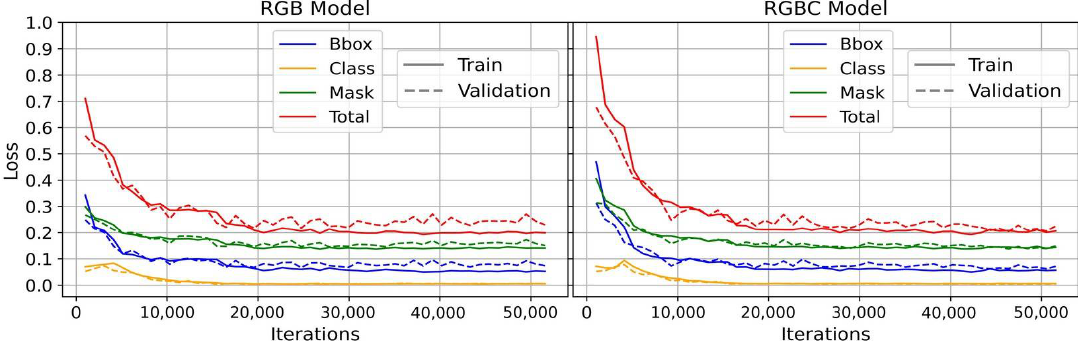
Figure 5. Evolution of validation metrics during Mask R-CNN training.